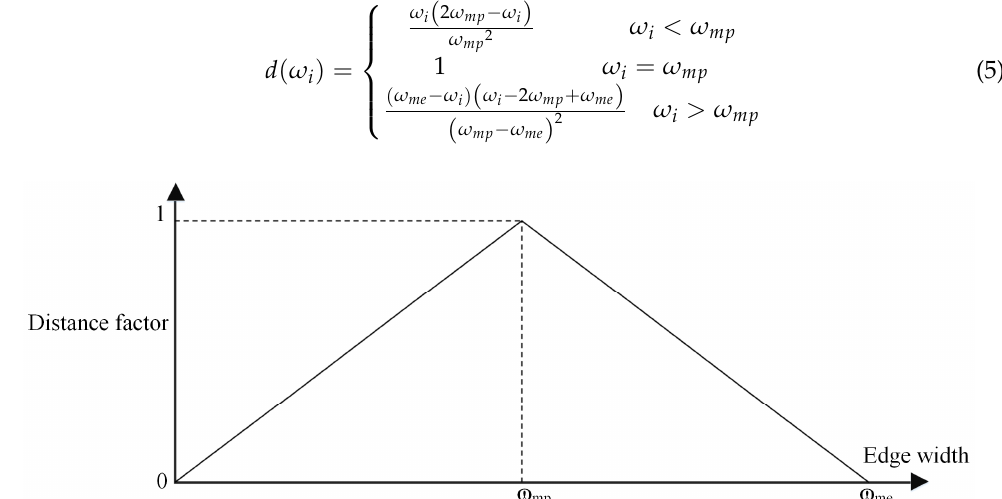
Figure 13. The distance factor variation relationship in Equation (4).